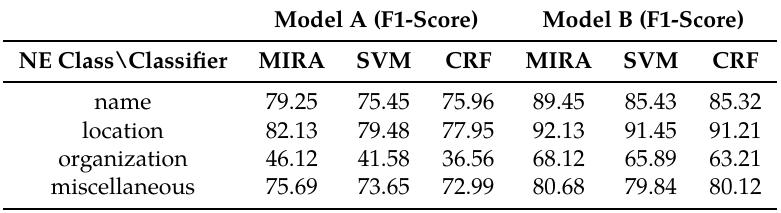
Table 16. Experimental results of each NE class on the test set for Models A and B in terms of